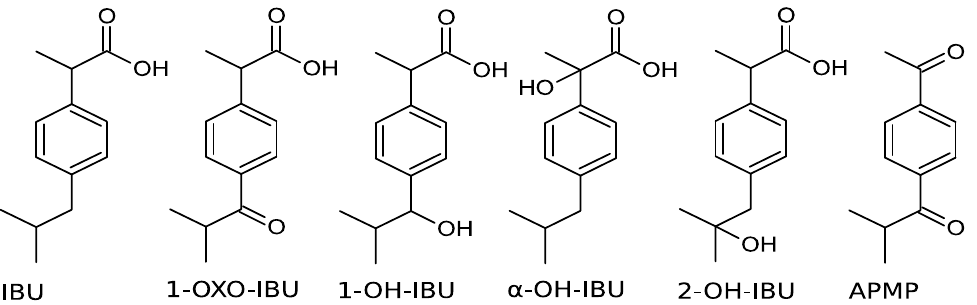
Figure 6. Structural formulas of IBU and the by-products detected.